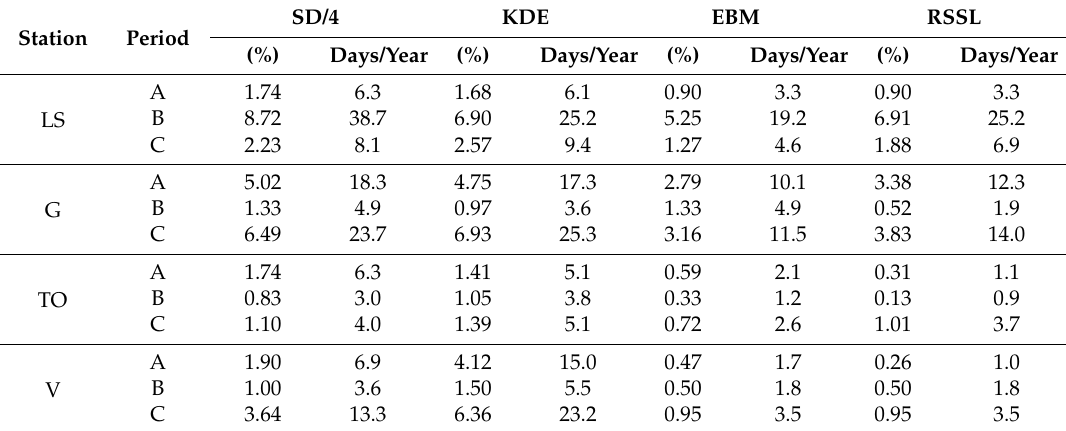
times equalling or exceeding Q eff<bf , the values range between 12% and 42% (Figure 8). In general, the values are close to those presented by Klonsky and Vogel [23] for the 15 sites chosen to be representative of all types of rivers throughout the United